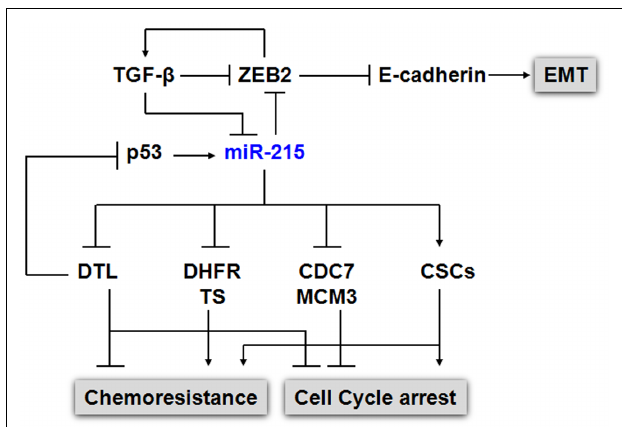
FIGURE 1 | Impact of miR-215 on cell proliferation, cell cycle, chemoresistance, and EMT. p53 and miR-215 form a positive feedback regulatory mechanism to regulate cell cycle control.The expression of p53 was induced by the suppression of DTL, a critical component of the e CUL4A–DDB1 E3 ubiquitin ligase complex, along with the p53 down stream gene p21.The elevated p53 in turn up-regulates the expression of miR-215. In addition, to DTL, miR-215 also suppresses the expression of TS, DHFR, CDC7, MCM3, MCM10. miR-215 triggers cell cycle arrest at the G2/M phase without triggering cell death, which contribute to chemoresistance toTS and DHFR inhibitors in CSCs. miR-215 also mediates EMT transition by targeting ZEB2 viaTGF β signaling